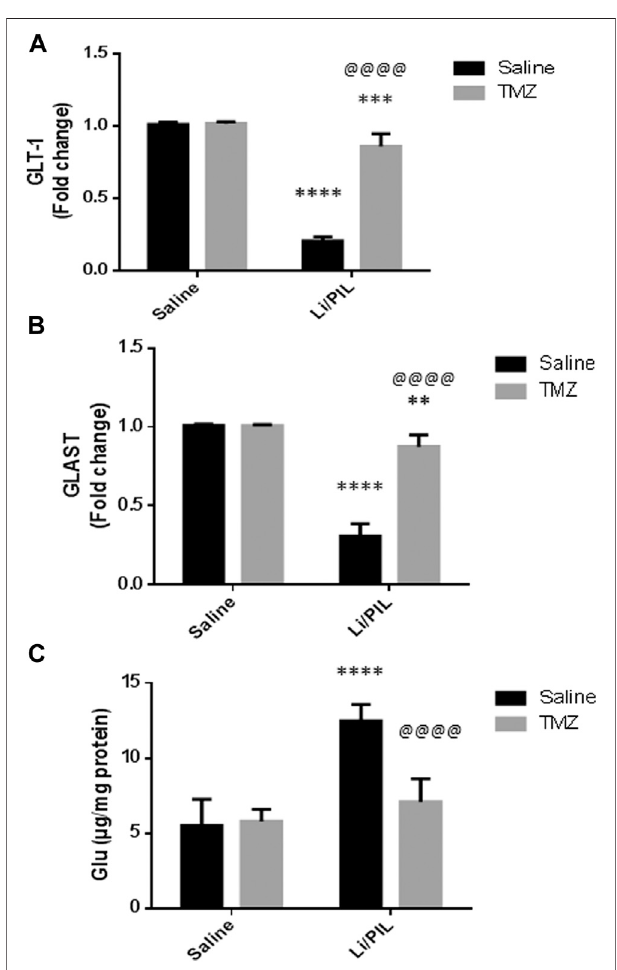
FIGURE 2 | Effect of TMZ on glial glutamate transporters and hippocampal glutamate level in rats with Li/PIL-induced seizures. (A) hippocampal mRNA expression of GLT-1 as indicated by qRT-PCR analysis, (B) hippocampal mRNA expression ofGLAST as indicated by qRT-PCR analysis, (C) hippocampal glutamate level. Values are expressed as mean of six animals ± SD. Two-way ANOVA followed by the Tukey – Kramer post-hoc test was used for statistical analyses of data. **Signi fi cantly different from the normal control group (Saline) at p < 0.01; ***Signi fi cantly different from the normal control group (Saline) at p < 0.001; ****Signi fi cantly different from the normal control group (Saline) at p < 0.0001; @@@@ Signi fi cantly different from the Li/PIL control group at p <